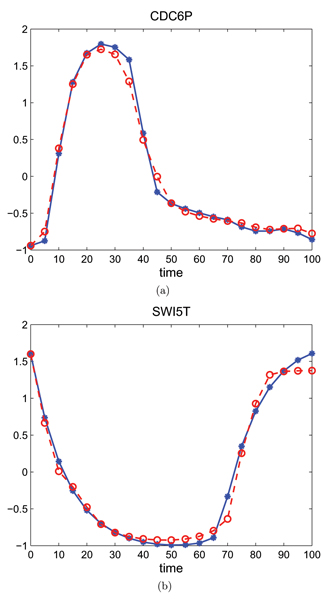
Examples of fitted profiles. Plots of the observed (continuous blue line) and fitted profile (dashed red line) for two analyzed variables, obtained using the nonlinear models corresponding to α = 0.6 (a) and α = 2 (b). Time is expressed in minutes.